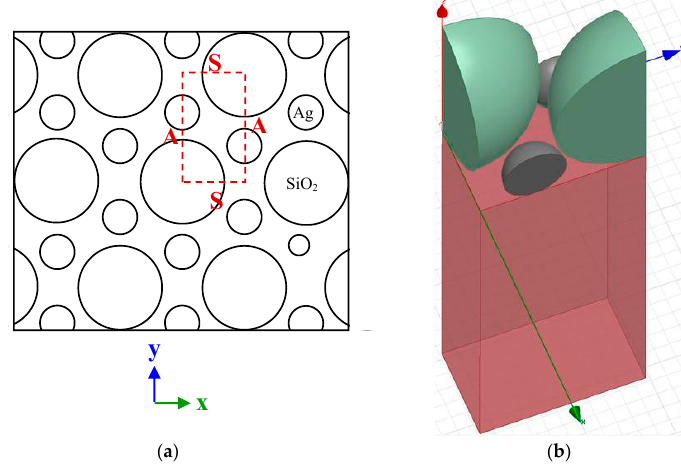
Figure 1. ( a ) Top view of the cell to be optimized. S stands for symmetric boundary condition and A for anti-symmetric. ( b ) 3D view of the analysis domain: the nanoparticles are placed at z = 0 and the domain is truncated at z = 500 nm and z = − 500 nm by means of two Perfectly Matched Layers.